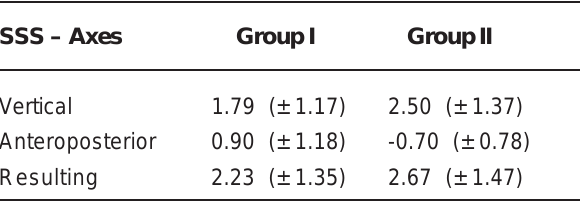
TABLE 1- Mean values for SSS (in mm; ± standard deviation) according to vertical and anteroposterior axes and resulting measures TABLE 2- Vertical and horizontal overlap mean values (in